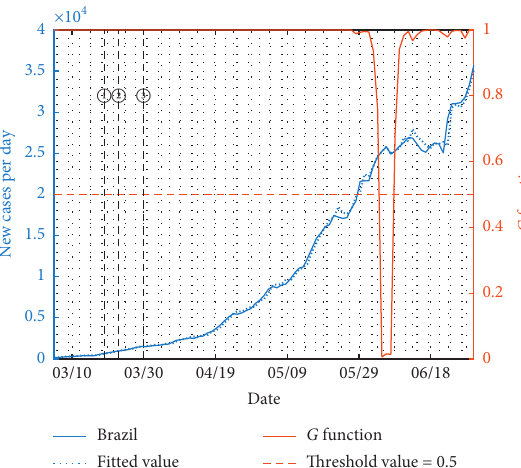
Figure 13: The fitting result of Brazil. The left axis shows the daily confirmed cases for the real data after smoothness (blue solid line) and its fitted values by the STAR model (blue dashed line). The right axis shows the value of nonlinear functions G changing with time (orange solid line) and the reference line with threshold 0.5 (orange dashed line). The vertical dotted line indicates the sequential released policies: ① close borders with Argentina , Bolivia, Colombia, Guyana, French Guiana, Paraguay, Peru, and Suriname within 15 days, ② ban foreigners by air from China, European Union, Iceland, Norway, Switzerland, the United Kingdom, Australia, Japan, Malaysia, and South Korea, and ③ implement the lockdown policy.